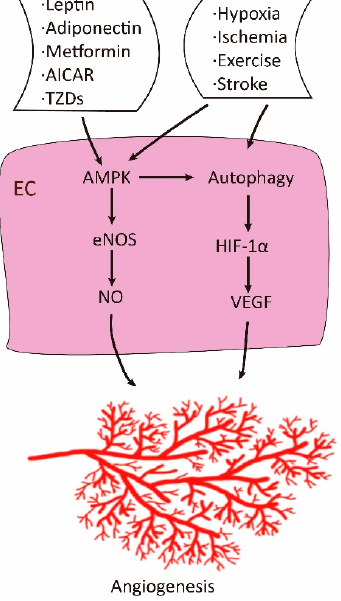
Figure2. Positiveroleofadenosine5 (cid:48) -monophosphate-activatedproteinkinase(AMPK)inangiogenesis. Under physiological conditions, AMPK is activated by ligands, pharmacological agents, and stresses. Activated AMPK promotes angiogenesis via increased production of NO and vascular endothelial growth factor